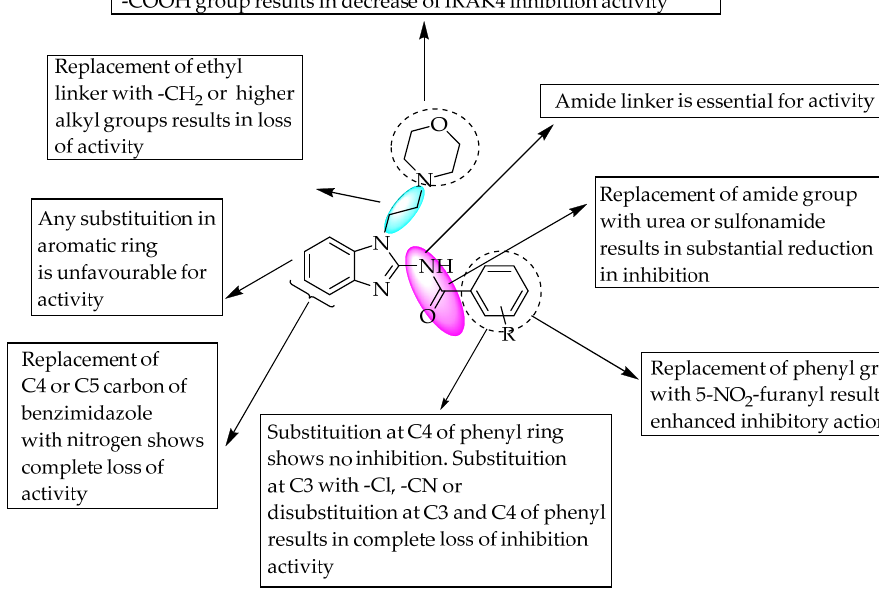
Figure 18. SARs of 2-acetamidopheny-1-(N-substituted) benzimidazoles.